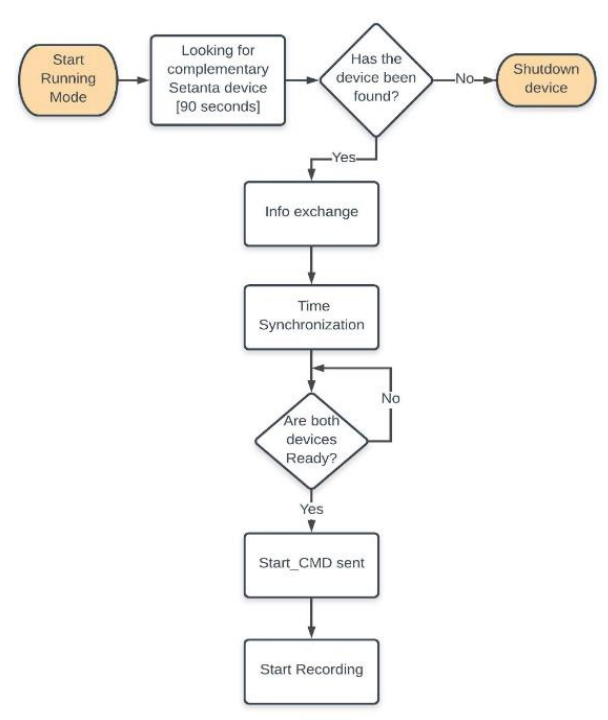
Figure 5. “Running” mode flowchart.